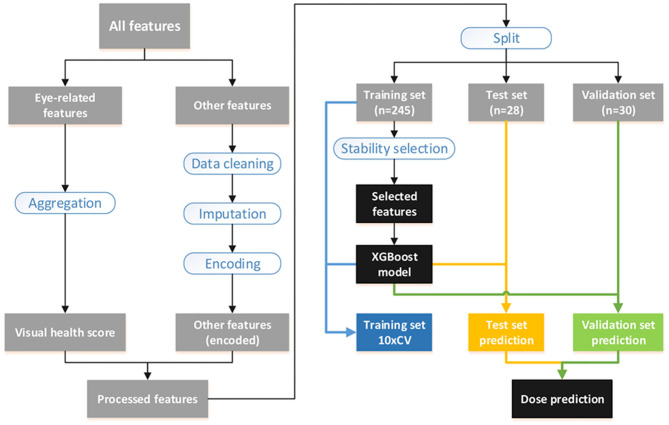
Workflow overview.